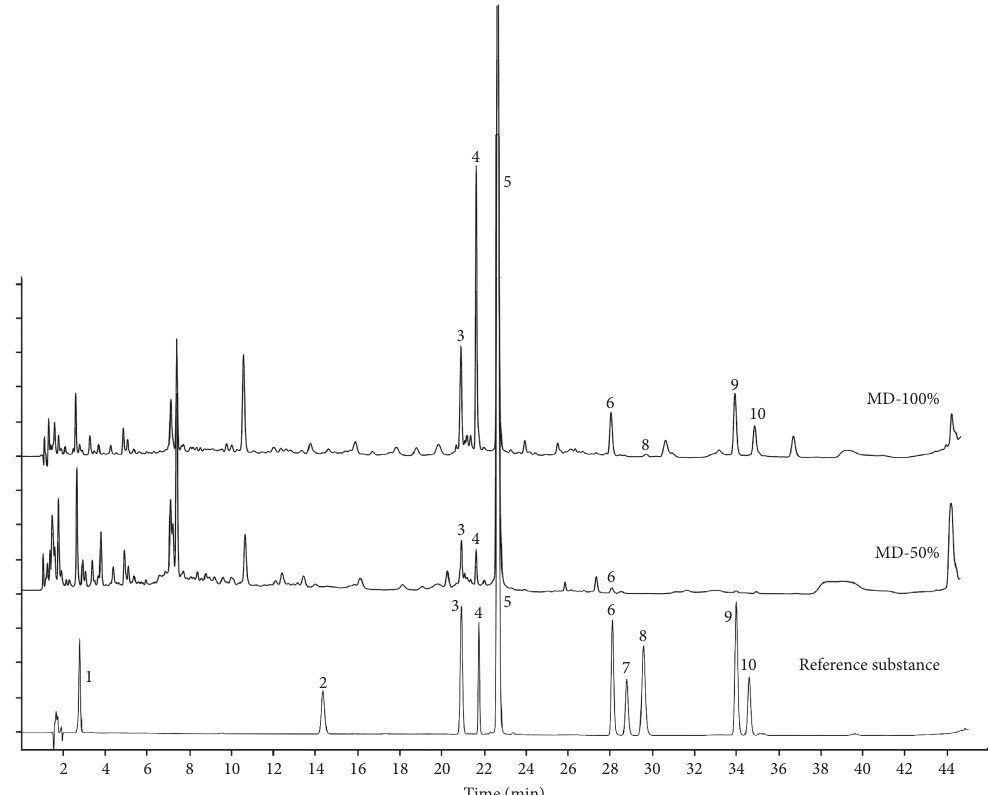
Figure 6: Representative HPLC chromatograms of standard solution and eluted fractions (1, gallic acid; 2, P- coumaric acid; 3, vitexin; 4, isovitexin; 5, ellagic acid; 6, quercetin; 7, naringin; 8, luteolin; 9, kaempferol; 10,